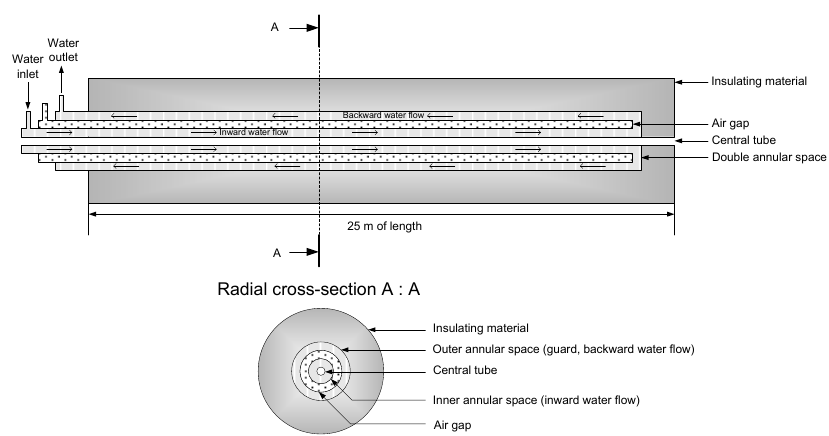
Figure 5. Schematic view of the 25 m horizontal furnace. Adapted with permission from [20]. Copyright 2016 IOP Publishing.